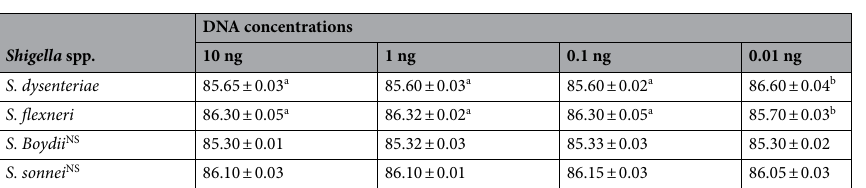
Table 3. Melting temperatures (T m ± SD (°C)) in PCR-HRM assay of melting curves of DNA tenfold dilution series for all Shigella species using rrsA primer. SD Standard deviation, T m Melting temperature, NS Not significant, Different letters in each row showed significant differences ( P <